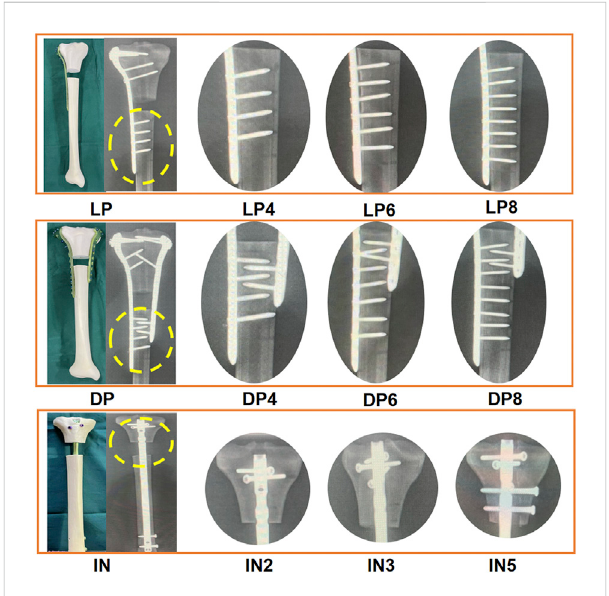
FIGURE 1 Photographs and radiographic images depicting the nine subgroups that utilized various fi xation strategies. Lateral plate fi xation group (LP): four distal locking screws (LP4), six distal locking screws (LP6), and eight distal locking screws (LP8). Double plate fi xation group (DP): Four distal locking screws of the lateral plate (DP4), six distal locking screws of the lateral plate (DP6), and eight distal locking screwsofthelateralplate(DP8).Intramedullarynailinggroup(IN):Two proximal interlocking screws (IN2), three proximal interlocking screws (IN3), fi ve proximal interlocking screws